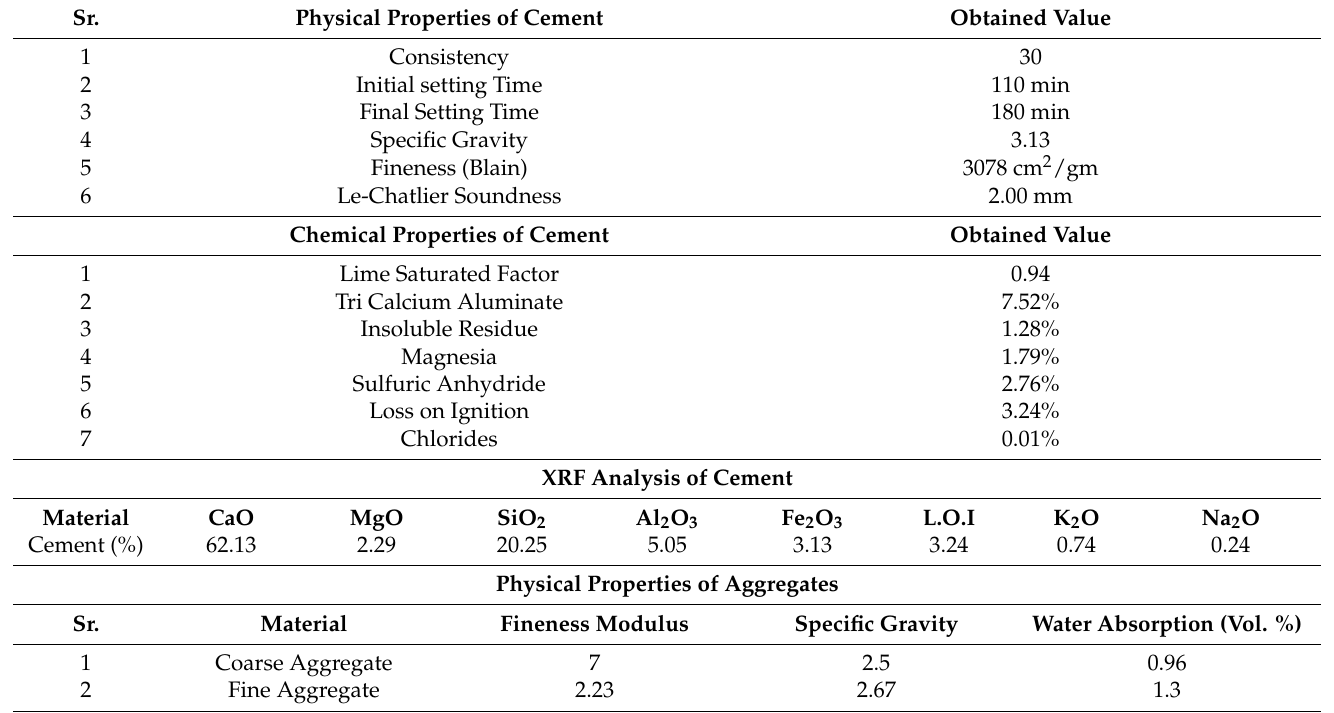
Table 1. Properties of Cement and Aggregate.